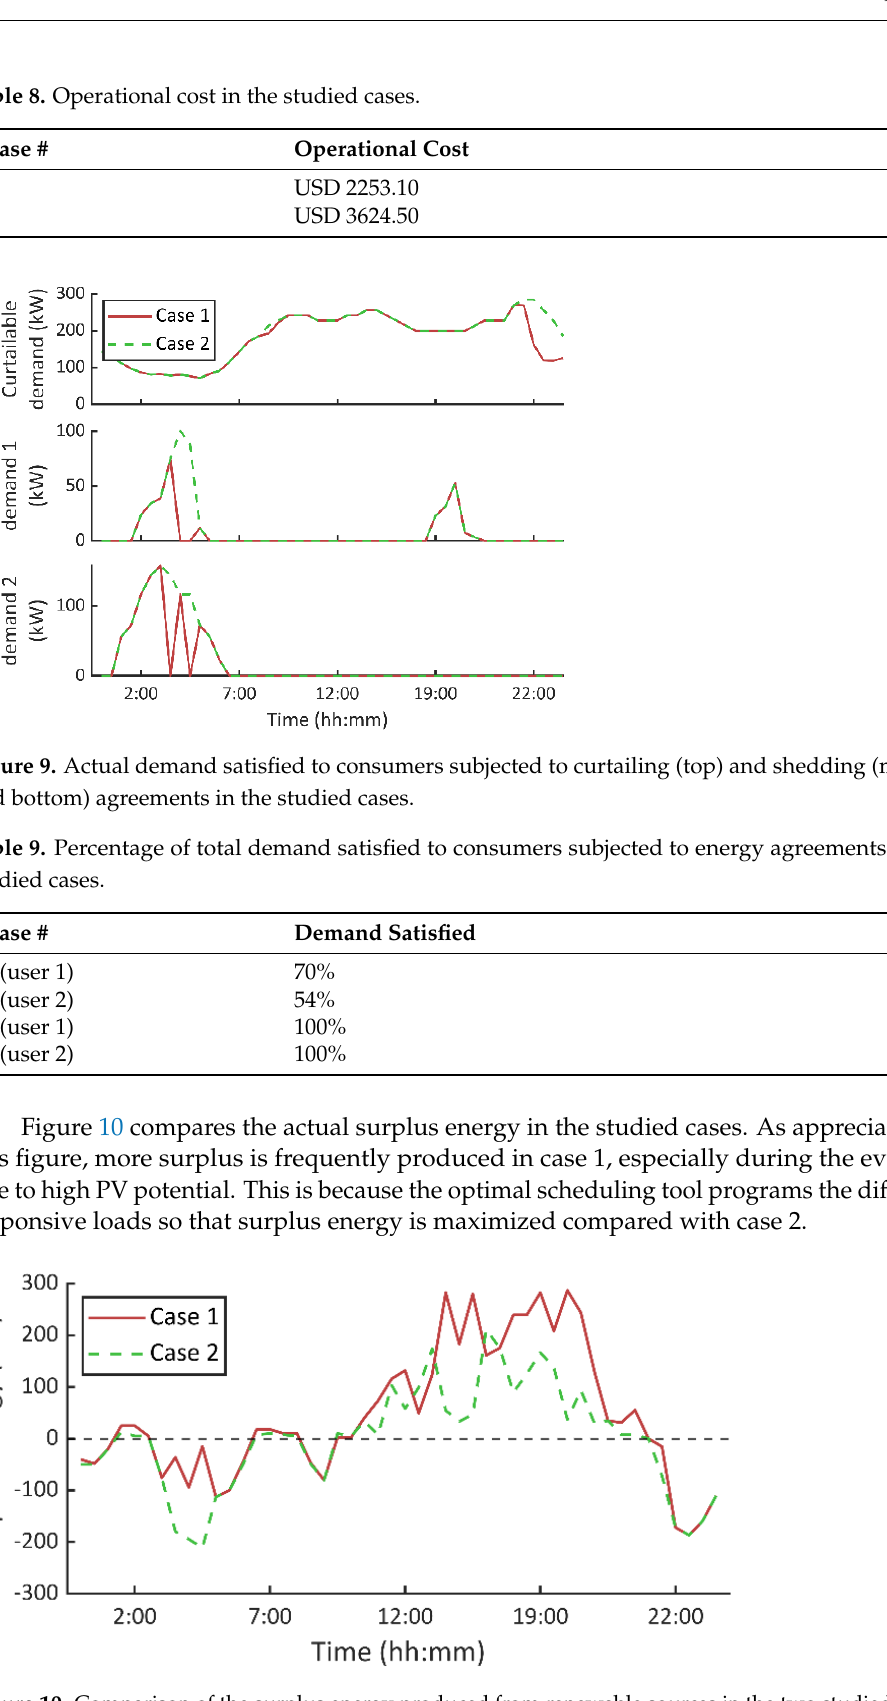
Figure 10. Comparison of the surplus energy produced from renewable sources in the two studied cases.